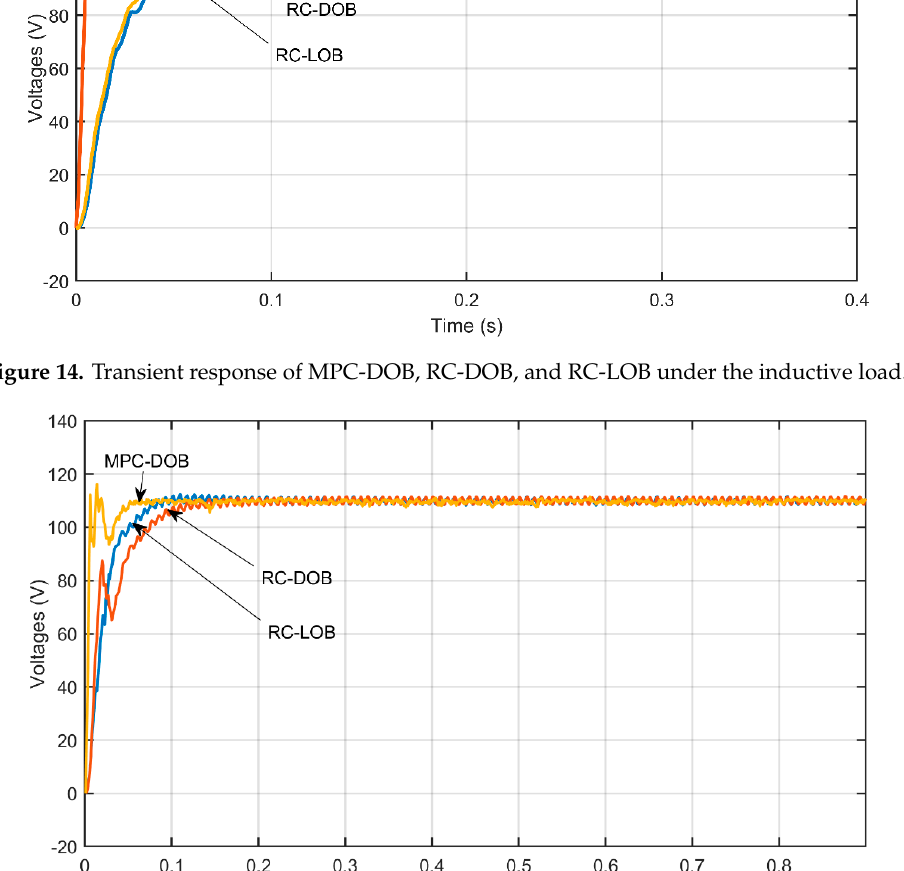
Figure 16. Transient response of MPC-DOB and RC-DOB under the nonlinear load with different filter parameters ( (cid:2015) = 7.5) .